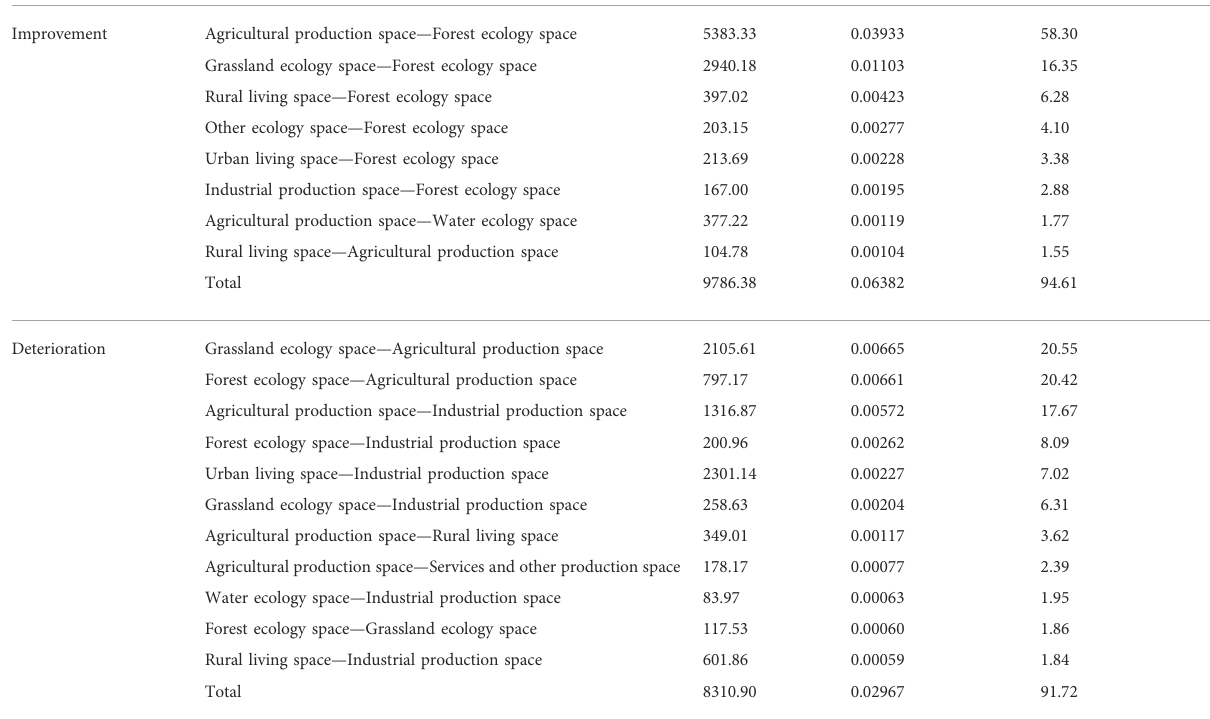
TABLE 6 Main land-use transitions and their eco-environmental contribution rate (hm 2 ,